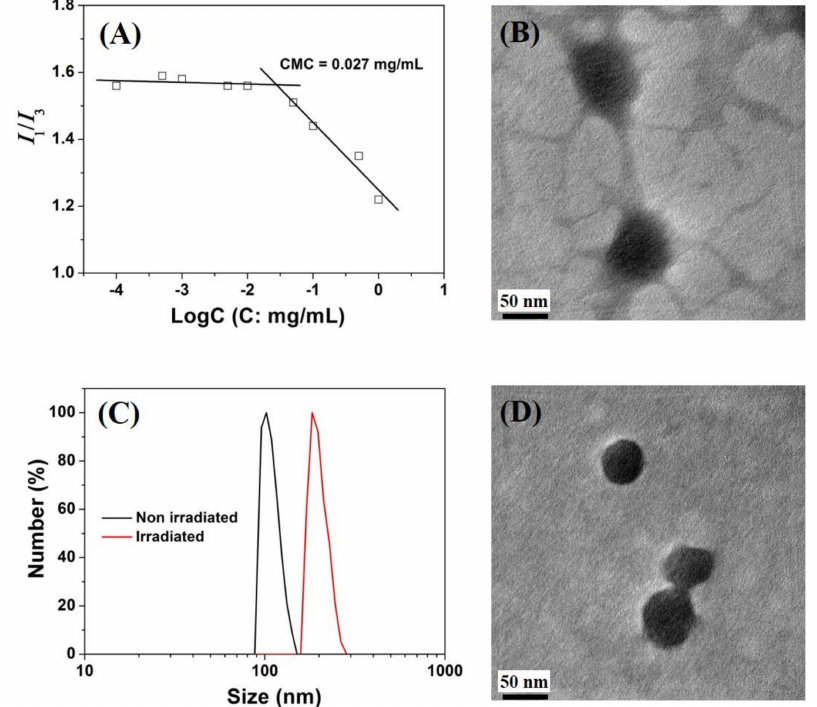
Figure 3. ( A ) Intensity ratio ( I 1 / I 3 ) of the pyrene emission spectra versus the logarithm concentration of CMCS-DEACMS-2 micelles; ( B ) TEM images of CMCS-DEACMS-2 micelles; ( C ) DLS results of CMCS-DEACMS-2 micelles before and after irradiation under simulated sunlight; ( D ) TEM images of CMCS-DEACMS-2 micelles after irradiation under simulated